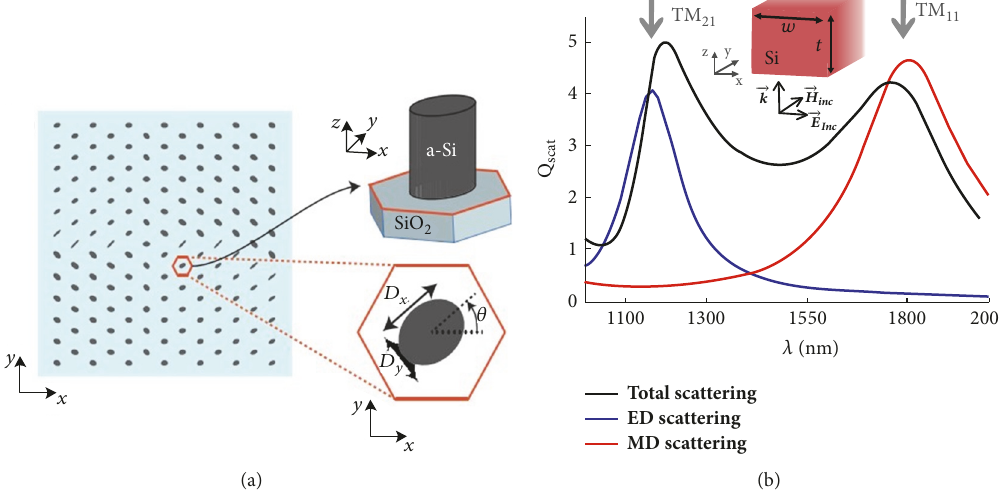
Figure 10: (a) The metasurface consists of an elliptic amorphous silicon column with the same height, different diameters (Dx and Dy), and different azimuthal angles ( 𝜃 ). The columns are located in the center of the hexagonal cell (pixel). (b) Rectangular dielectric nanoparticles also exhibit electromagnetic field polarizability. The figure shows the electric dipole (ED) and the magnetic dipole (MD)